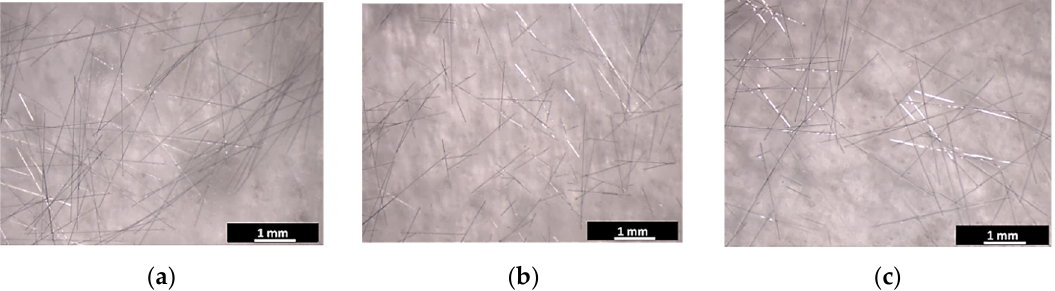
Figure 6. Microscopic images of 3 mm-CFs mixed with ( a ) spatula, ( b ) shear mixing, and ( c ) ultrasounds for 5 min.